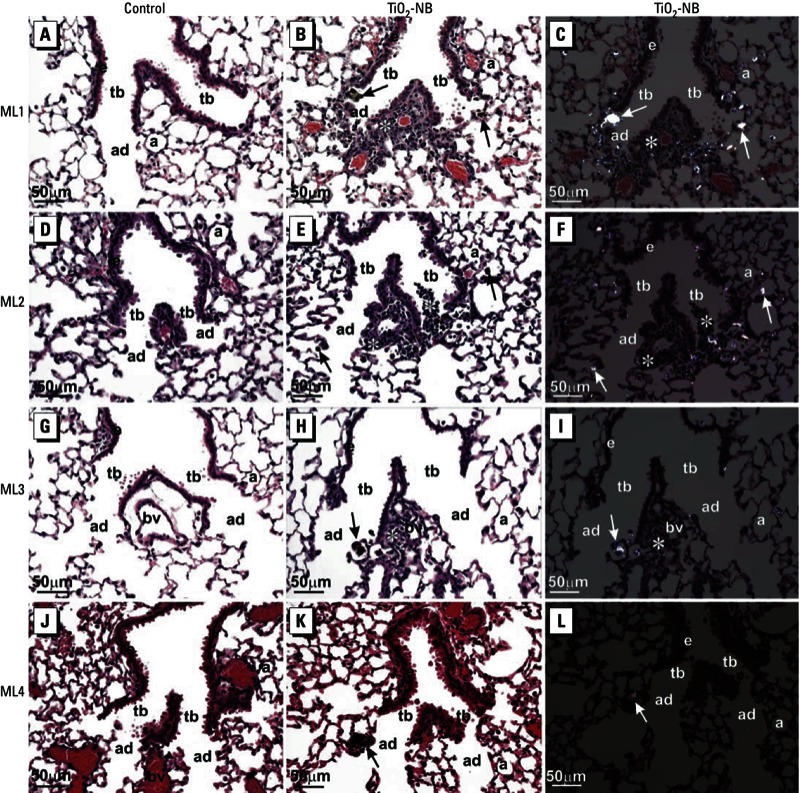
Photomicrographs of H&E-stained lung tissue 1 day after exposure of C57BL/6 mice to DM alone (control; A, D, G, J) or TiO2‑NB at 40 μg/50 µL DM (B, C, E, F, H, I, K, L). Photomicrographs are representative sections from each of the four labs: (A–C) ML1, (D–F) ML2, (G–I) ML3, and (J–L) ML4. (A, D, G, J, B, E, H, K) Bright-field light microscopy of representative sections of lung from control mice (A, D, G, J) and TiO2‑NB–exposed mice (B, E, H, K); sections from TiO2‑NB–exposed mice show inflammatory lesions primarily localized to alveolar duct bifurcations. (C, F, I, L) Polarized light microscopy of the same images shown in B, E, H, and K show inflammation at an alveolar duct bifurcation. Abbreviations: a, alveolus; ad, alveolar ducts; bv, blood vessel; e, airway epithelium; tb, terminal bronchioles. Arrows indicate TiO2‑NBs within macrophages at alveolar duct bifurcations, and asterisks (*) indicate inflammatory foci. All photo­micrographs were taken at the same magnification; bar = 50 μm.